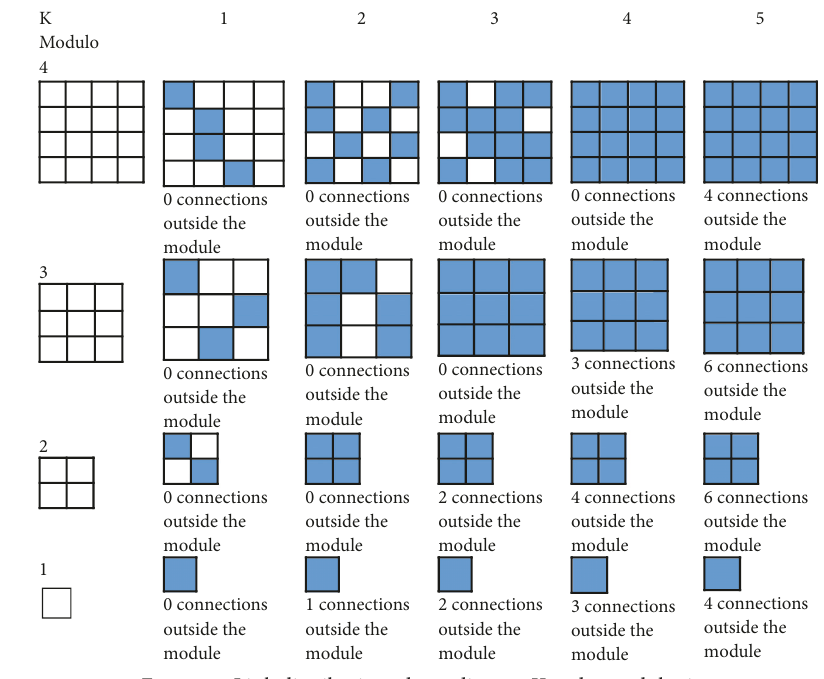
Figure 7: Link distributions depending on 𝐾 and a module size.